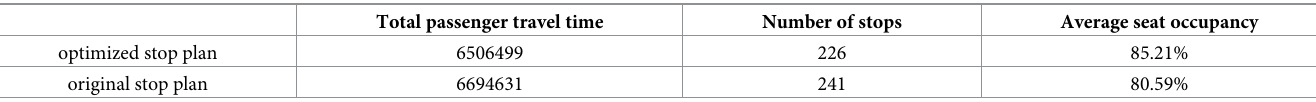
Table 9. Comparison of evaluation indexes for original and optimized stop